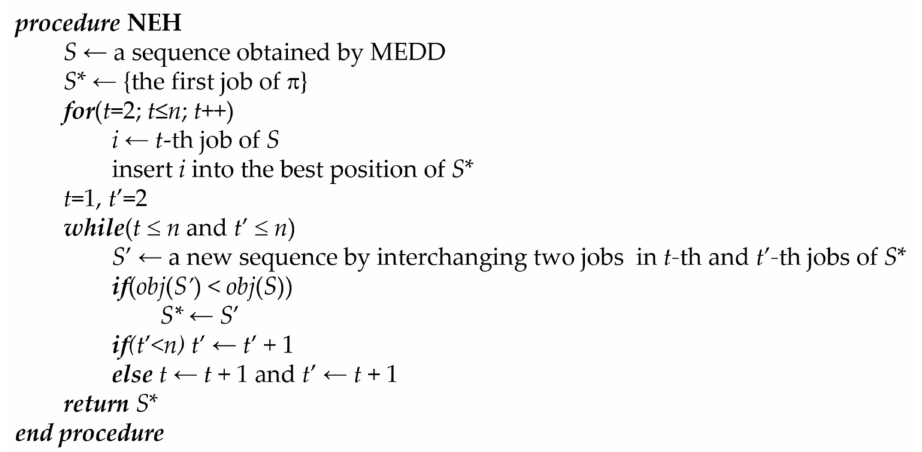
Figure 1. Procedure of the proposed NEH